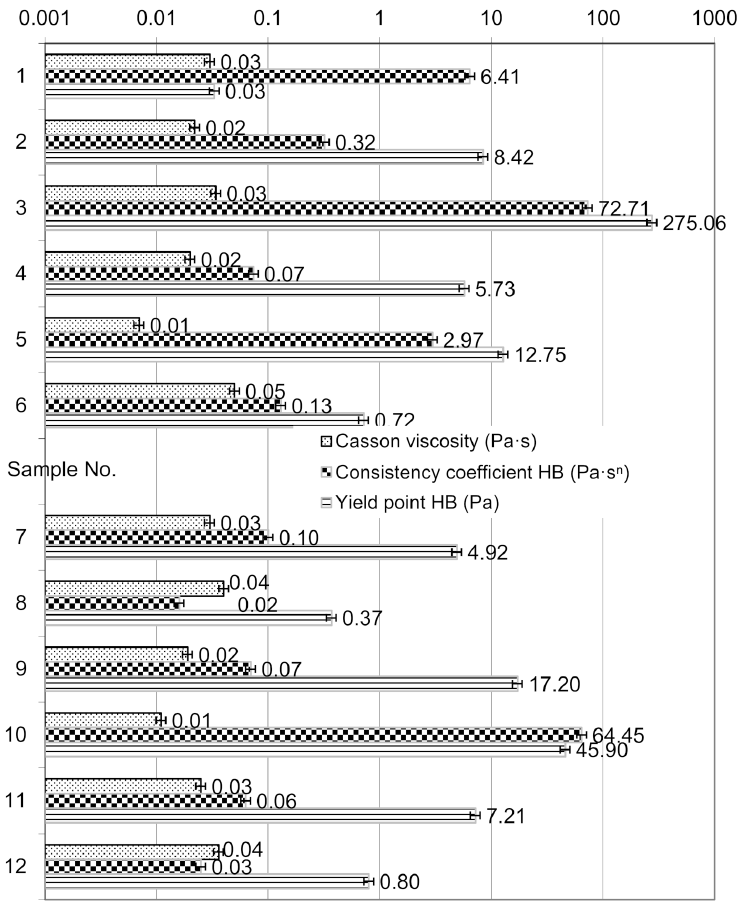
Figure 5. Values of rheological parameters of the tested cement slurries. Tests at a temperature of 20 ◦ C and atmospheric